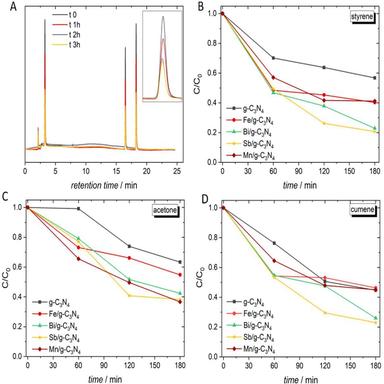
Photocatalytic degradation of VOCs. Chromatograms measured during 3 h test in the presence of the g-C3N4, inset: enlarged peak of cumene (A). Degradation curves of gaseous (B) styrene, (C) acetone, and (D) cumene under irradiation by λ = 400 nm LED in the presence of various photocatalyst.